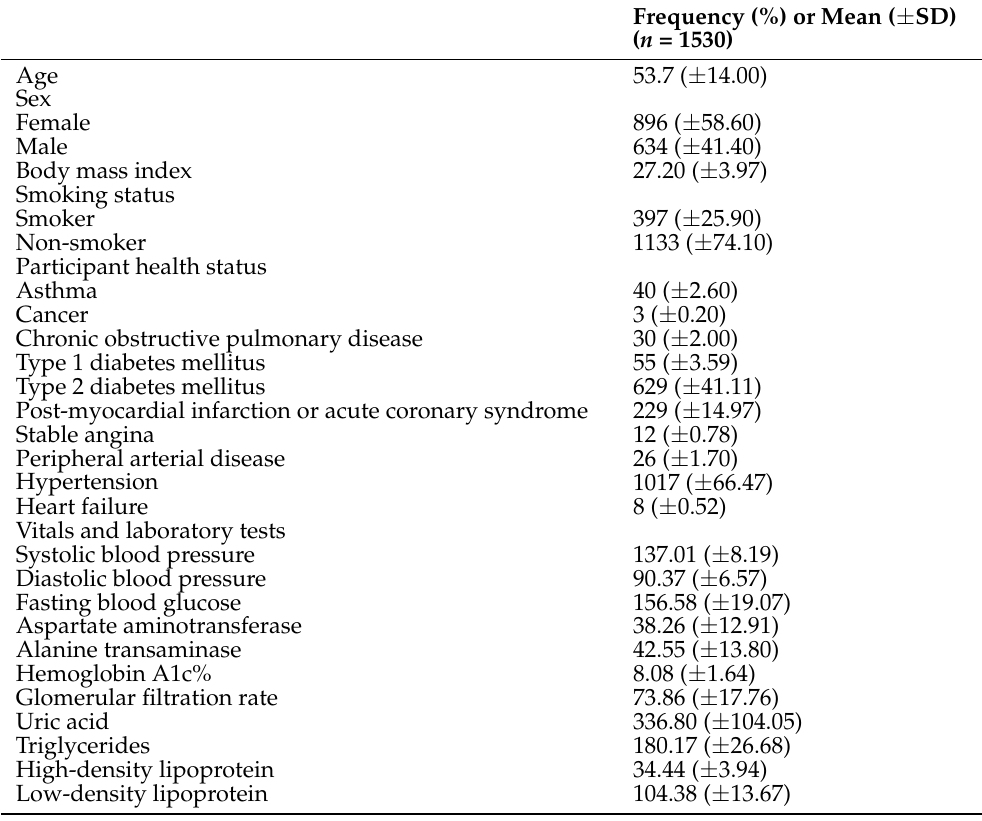
Table 1. Sample demographics and health